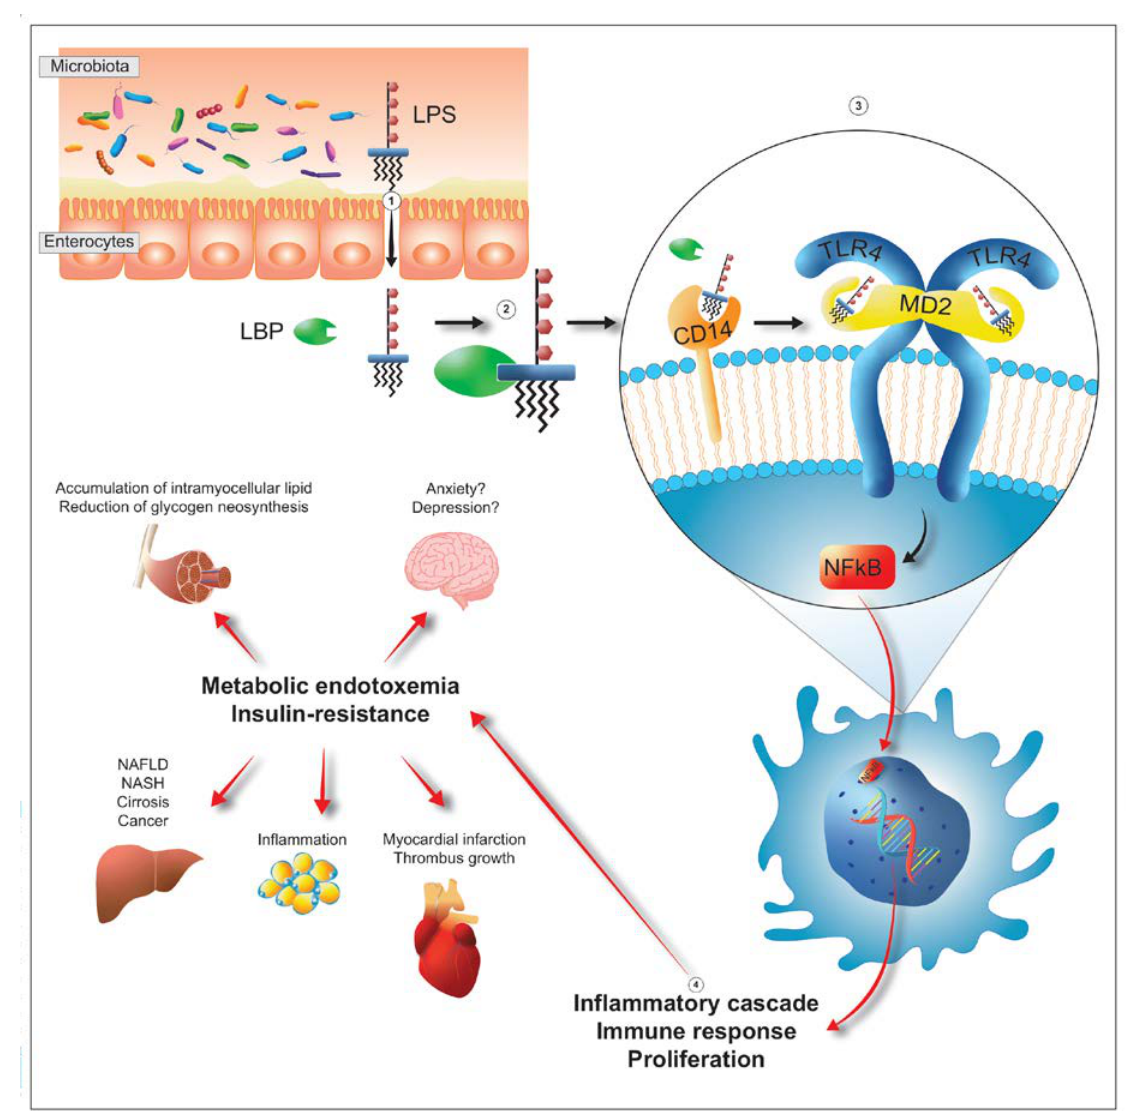
Figure 4. After passing the barrier formed by enterocytes (step 1), LPS interacts with the LPS-binding protein, known as LBP (step 2). The complex then interacts with the CD14 placed on the membrane of the target cells (step 3). Then, CD14 transfers LPS into the receptor pocket of the complex constituted by TLR4 (Toll-like receptor 4) and MD2 (myeloid differentiation-2) triggering a cascade of intracytoplasmic events which culminates with the entry of NFkB (nuclear factor kappa-light-chain- enhancer of activated B cells) into the nucleus and subsequent transcription and translation into proteins (mainly cytokines) with specific inflammatory characteristics (step 4). The presence of these cytokines, feeds phenomena such as metabolic endotoxemia and tissue insulin-resistance (step 5). Both, by acting on the different organs, have different consequences. In the liver, they promote the development of NAFLD (non-alcoholic fatty liver disease), NASH (non-alcoholic steatohepatitis), cirrhosis and cancer. In the striatal-skeletal musculature they promote accumulation of intramyocellular lipid and reduction of glycogen neo-synthesis. In the adipose tissue they promote inflammation. At cardiac and cardio-vascular levels they predispose individuals to an increased risk of myocardial infarction and thrombus growth. Finally, in the brain, they probably promote pathologies such as anxiety and